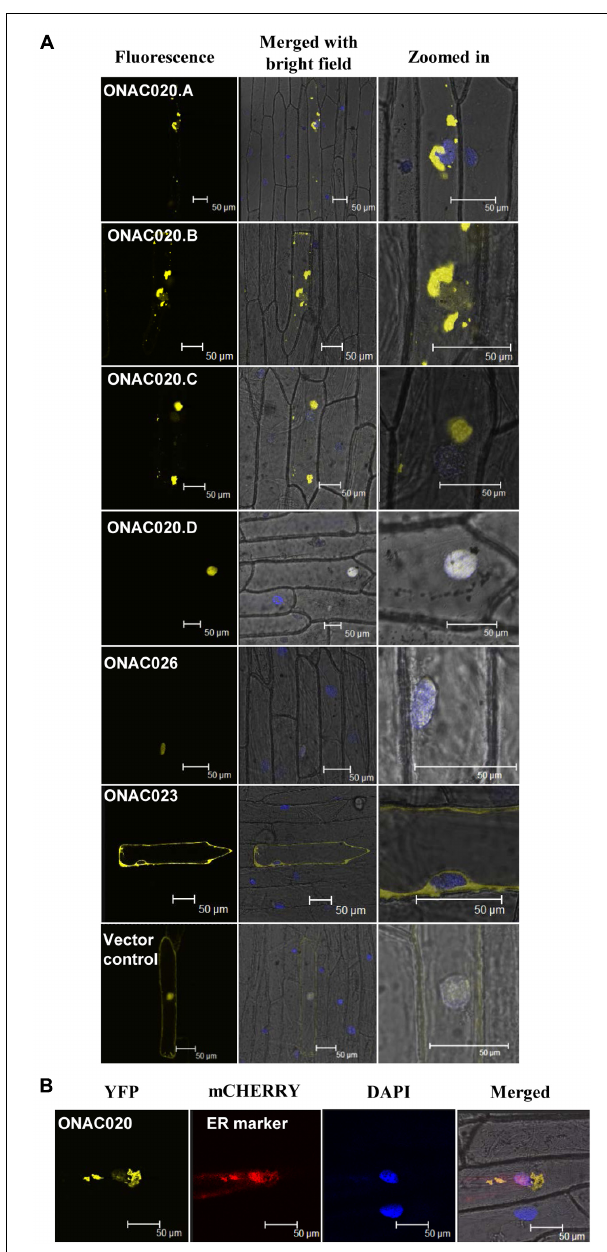
FIGURE 6 | Subcellular localization of NAC-YFP fusion proteins. (A) represents the localization images of the three main NAC TFs and the transcript fusion forms of ONAC020. The left column indicates the localization image of the YFP fusion protein at 514 nm. The middle column is the merger of bright field, fluorescence image and DAPI stained nucleus while the right column shows an enlarged image. (B) represents the co-localization of ONAC020 with endoplasmic reticulum (ER) marker. The protein names have been mentioned and the scale bar indicates 50 µ